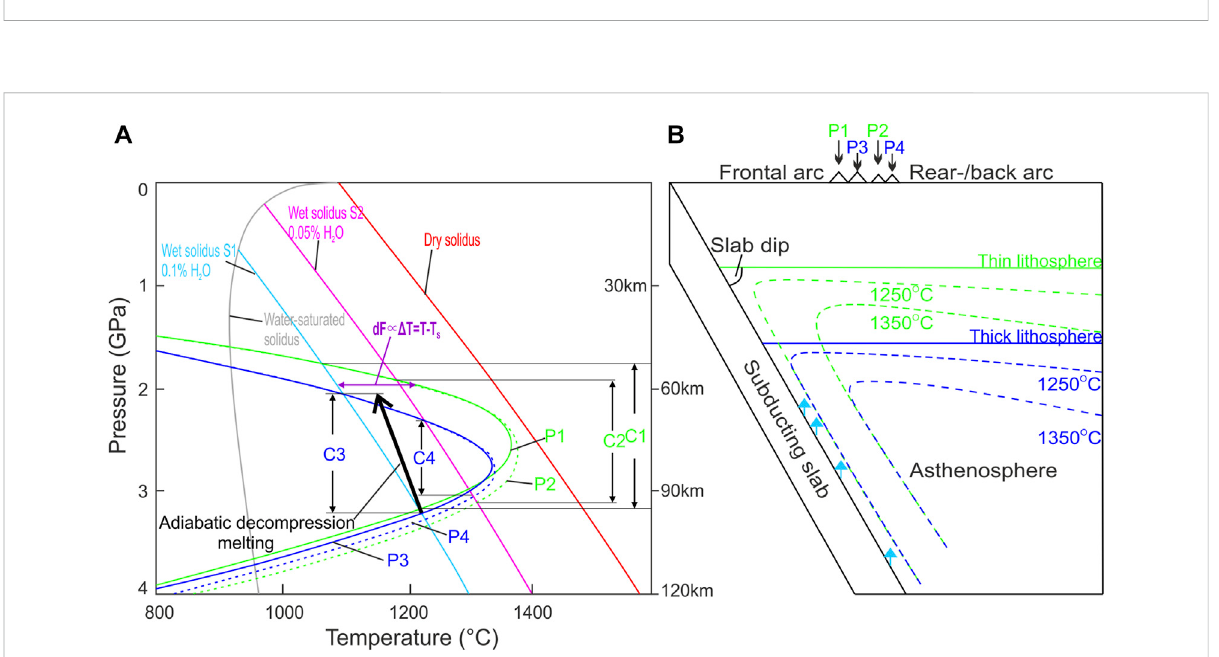
FIGURE 3 (A) Aphasediagramtoillustratehowcrustorlithospherethicknessandslab-derivedaqueous fl uidsexerttheireffectsonacross-andalong-arc variations through mantle melting degrees [solidus is from Katz et al., 2003: wet solidus S1 is the solidus with .1% water and wet solidus S2 is .05% water;geothermP1ismodi fi edfromHall,(2012)] (B) Asketchtoshowmantlethermalstructureunderthinandthickcrust[modi fi edfromTurnerand Langmuir (2015)]. 1) Flux melting. For along-arc variation caused by lithosphere thickness, the geotherm for the mantle wedge beneath thick lithosphere is more depressed than the one beneath thin lithosphere (e.g., P3 versus P1). Assuming the same wet solidus S1 for both cases, the average melting degrees for the whole melting column (the area between the wet solidus and wedge geotherm divided by the vertical length C betweenthetwointersectionpoints)beneaththicklithosphereislowerfortheonebeneaththinlithosphere(area[S1-P3]/C3vs.area[S1-P1]/C1).For across-arc variations caused by aqueous fl uids, the wet solidus for the rear-arc (solidus S2) is closer to the dry solidus than the solidus for the frontal arc magmatism (solidus S1). The average mantle melting degree for the rear-arc (area [S2-P2]/C2) is smaller than the one for the frontal arc. 2) Decompression melting. When explained by decompression melting, the melting degree is represented by the length of the melting column. For example,C1 > C2indicatesthemeltingdegreeoffrontalarcmantleishigherthanthatoftherear-/back-arcmantleandC1 > C3indicatesthemelting degree of the frontal arc mantle beneath thin lithosphere is higher than that beneath thick